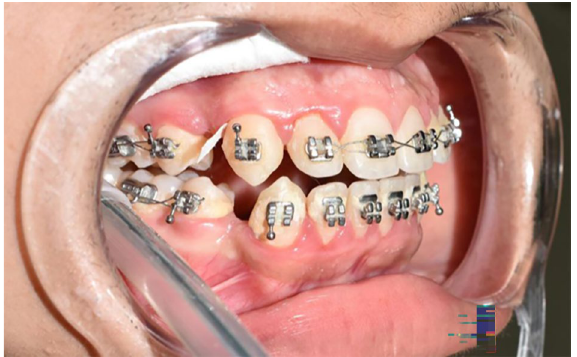
Figure 2. Collection of a GCF sample from the distal crevice of the maxillary canine.